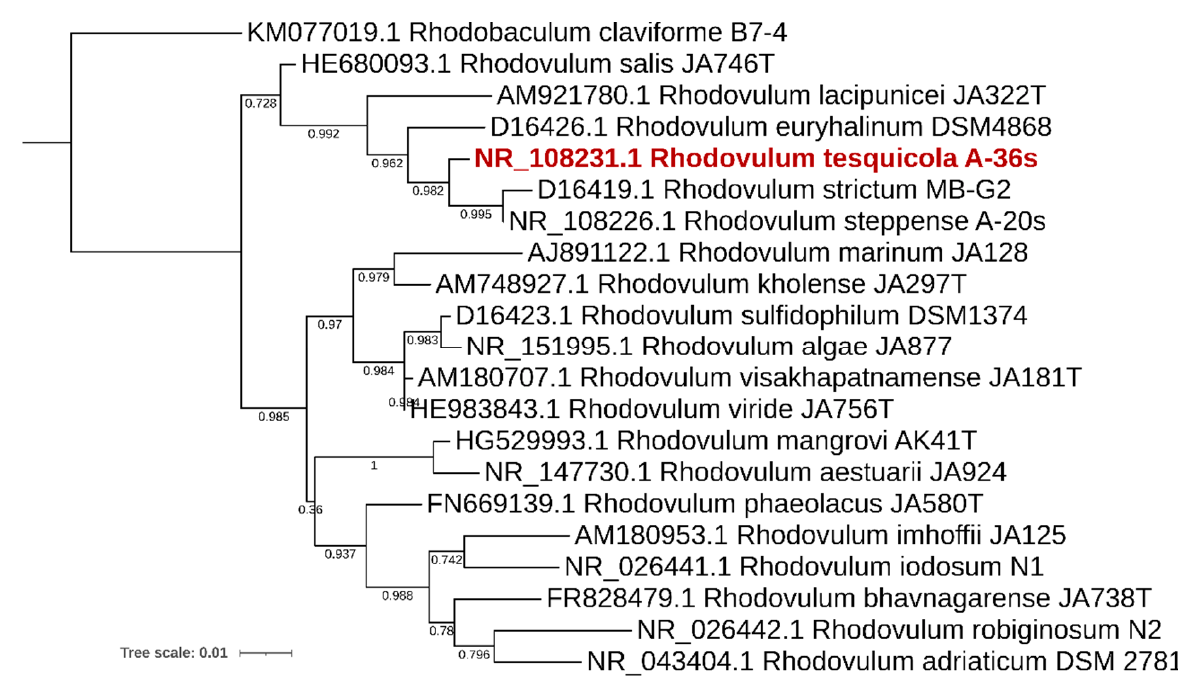
Figure 1. 16S rRNA gene phylogeny of the genus Rhodovulum . The tree is scaled by evolutionary distance (count of substitutions per site).